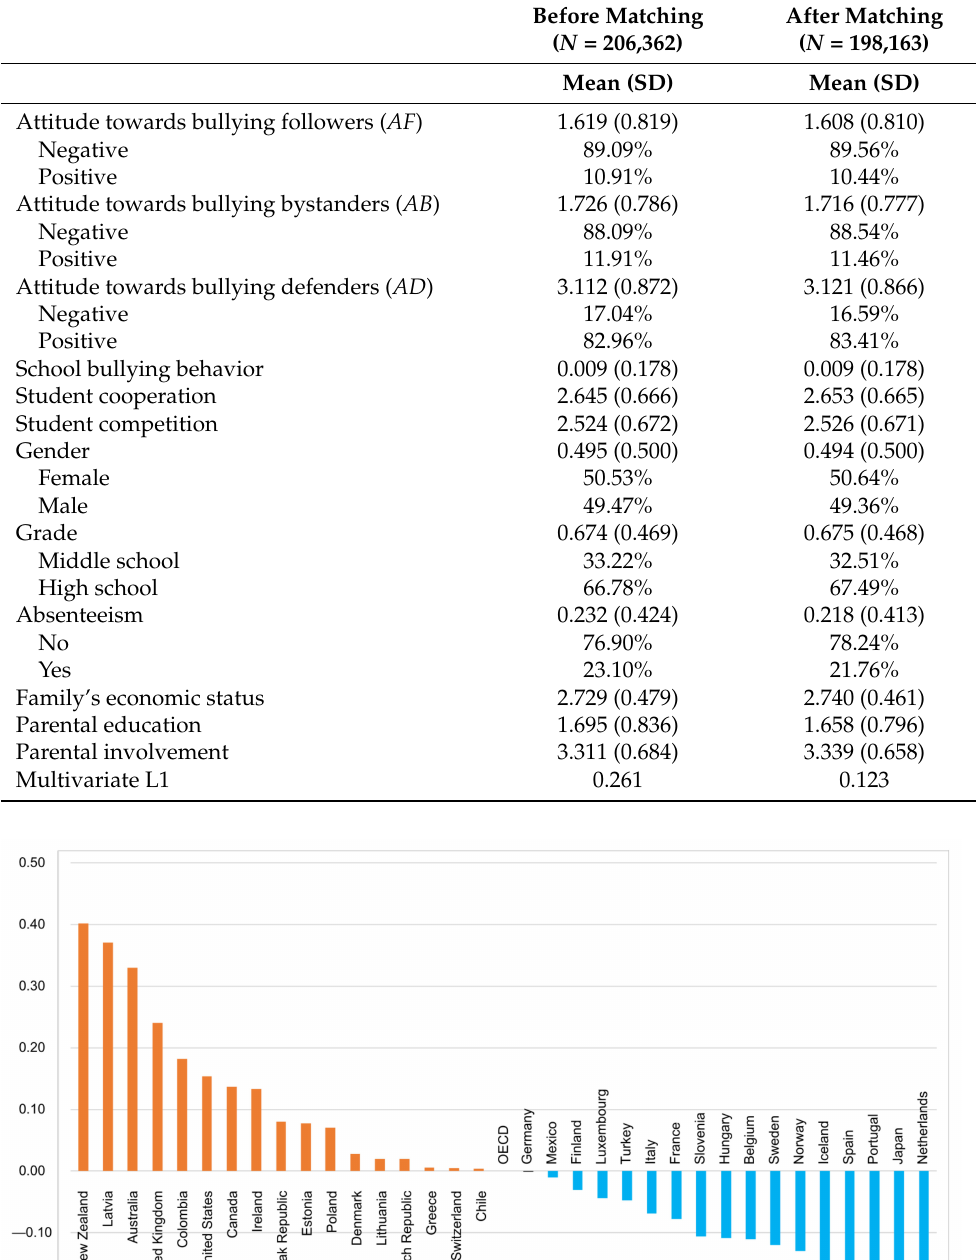
Table 1. Sample summary before and after the Coarsened Exact Matching (CEM) method.